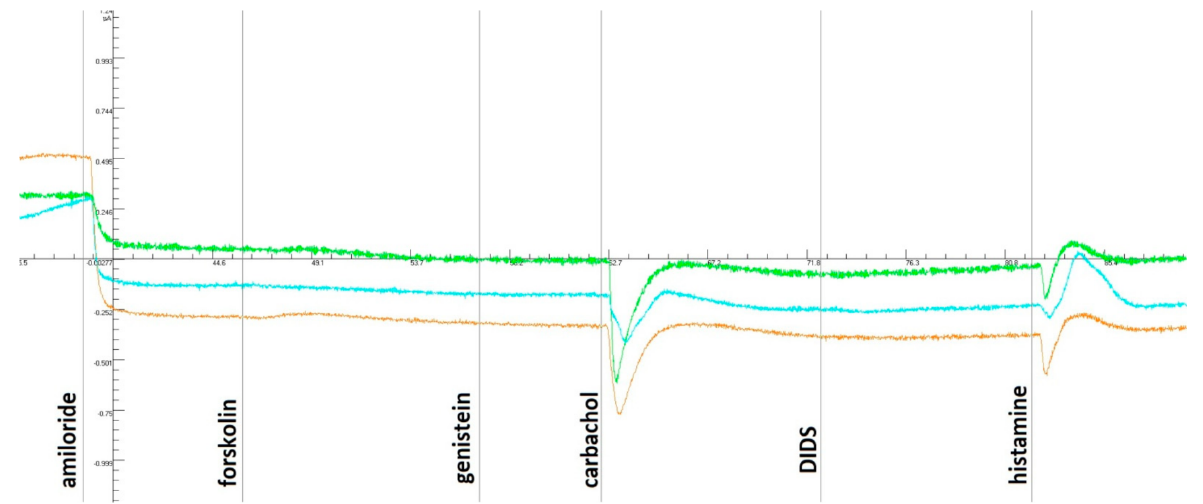
Figure 1. ICM measurements of the patient’s rectal biopsies before taking a tezacaftor/ivacaftor and ivacaftor. With the introduction of amiloride, there was a decrease in the ∆ ISC and no response to forskolin/IBMX, and a change in the ∆ ISC in the negative direction was observed with the addition of carbachol and histamine.